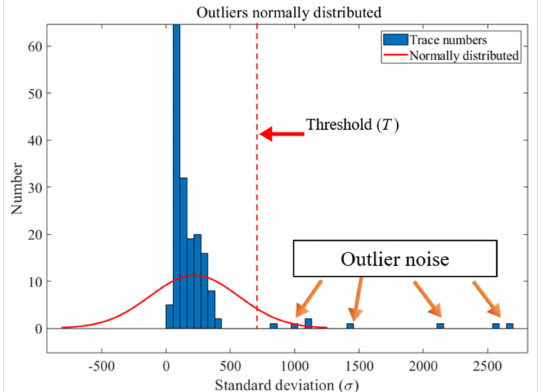
Figure 10. The statistical results of outlier noise for the noisy data.